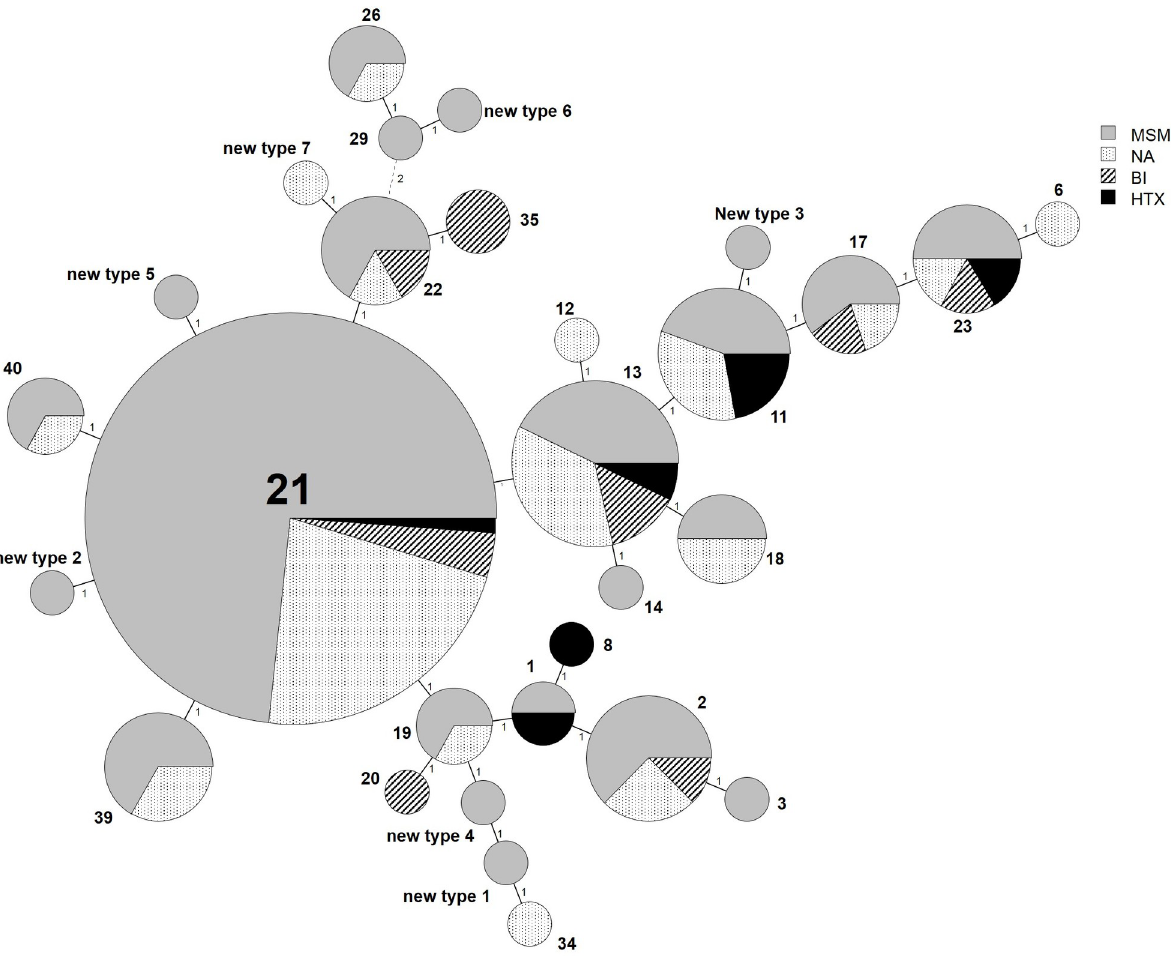
Fig 1. Minimum spanning tree of the MLVA-5 types of genovar E C . trachomatis clinical specimens according to sexual orientation. Each circle denotes a particular MLVA-5 type. The size of the circle is proportional to the number of specimens of the indicated MLVA-5 genotype. The distance between neighboring genotypes is expressed as the number of allelic changes. MSM: men who have sex with men (n = 110); BI: bisexual (n = 12), HTX: heterosexual (n = 7), NA: information not available (n = 43). https://doi.org/10.1371/journal.pone.0259274.g001 PLOS ONE | https://doi.org/10.1371/journal.pone.0259274 October 29,